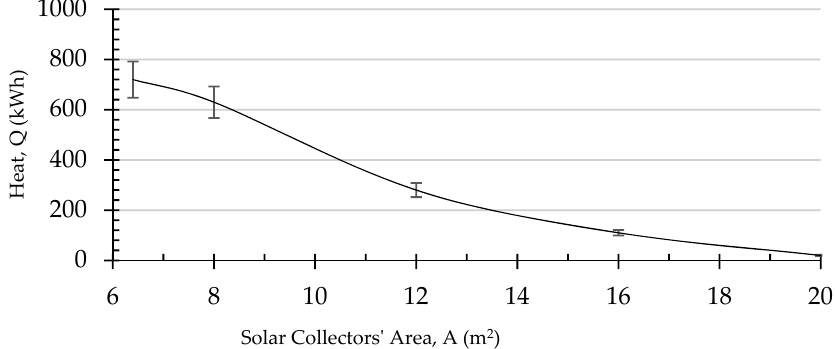
Figure 8. Additional load, Q, required to cover the building’s heating load with different solar collectors’ areas for January (percentage error bars shown, based on 10%).